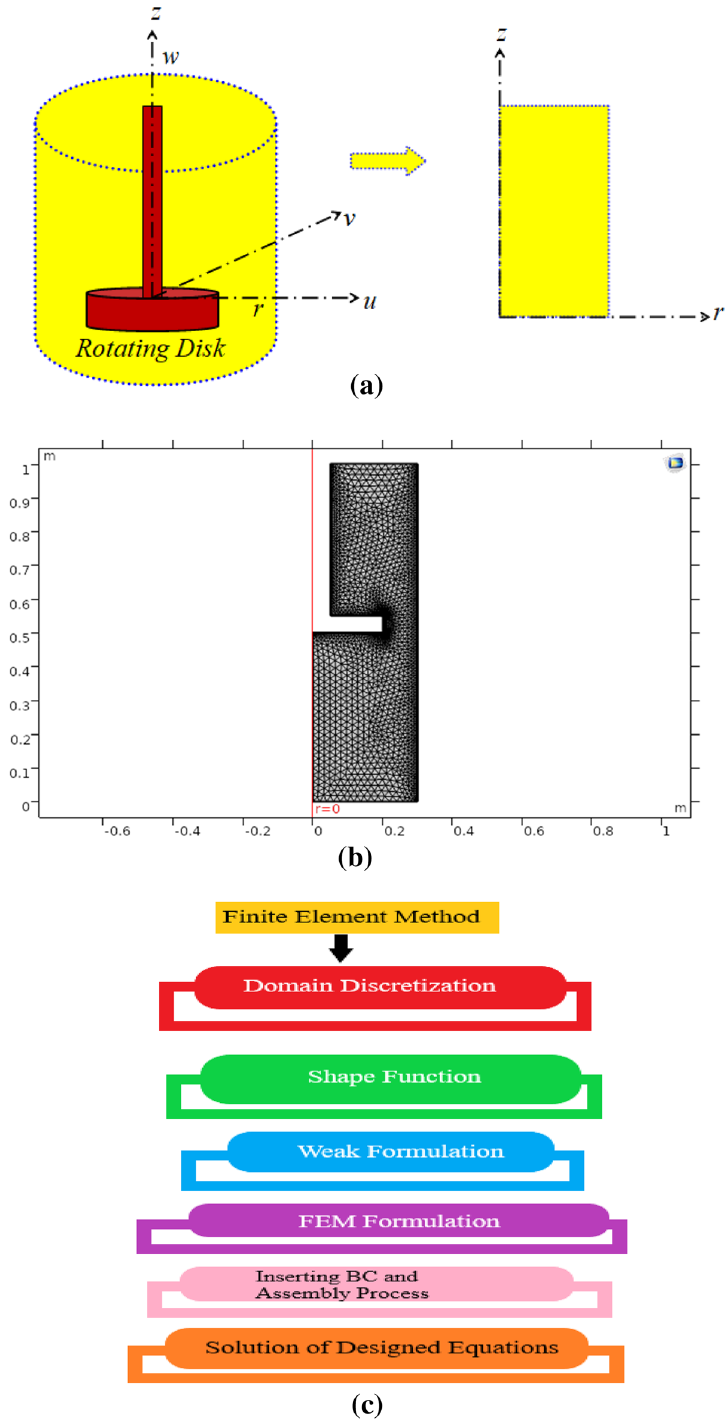
Figure 1. (a) Flow geometry of the problem, (b) rotating disk two-dimensional CFD domain mesh, (c) steps involved in the FEM